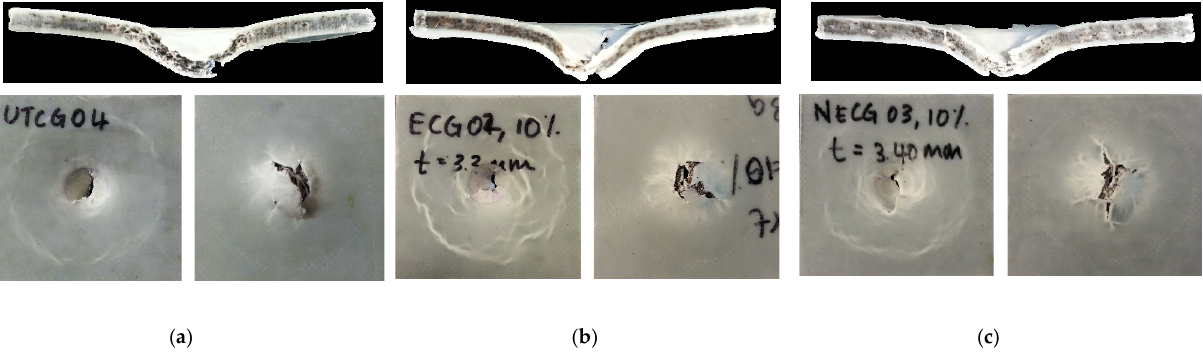
Figure 7. Effect of filler on ( a ) load, ( b ) energy to maximum, ( c ) total energy of GCW/HDPE composite at 10% particle loading.